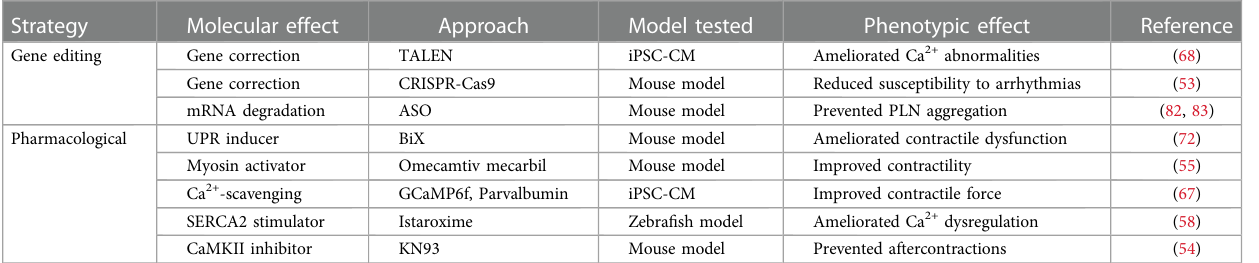
TABLE 3 Therapeutic approaches for